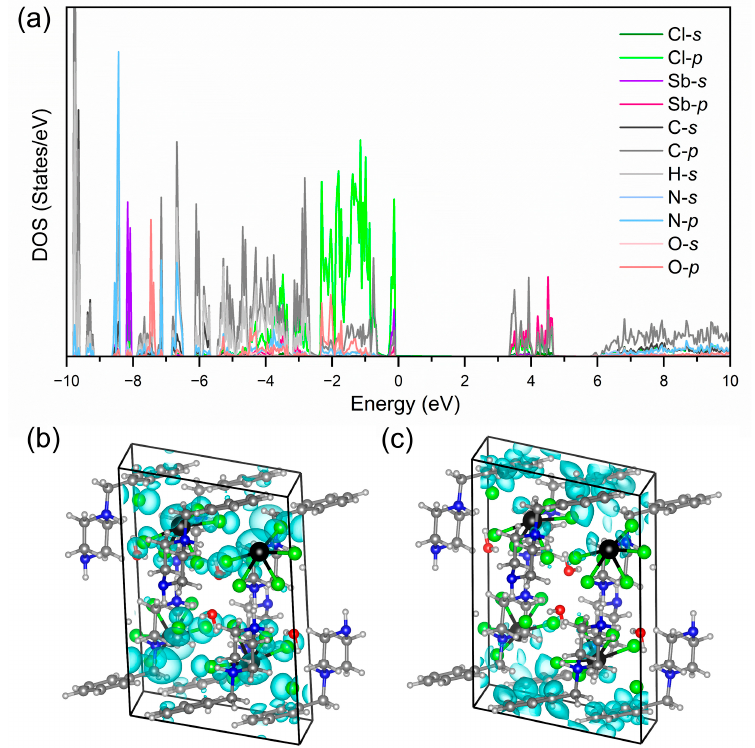
Figure 4. ( a ) The calculated orbital-resolved DOSs of [H 2 BPZ][SbCl 5 ]•H 2 O. The highest occupied molecular orbital (HOMO; ( b )) and lowest occupied molecular orbital (LUMO; ( c )) along the ac plane of [H 2 BPZ][SbCl 5 ]•H 2 O.